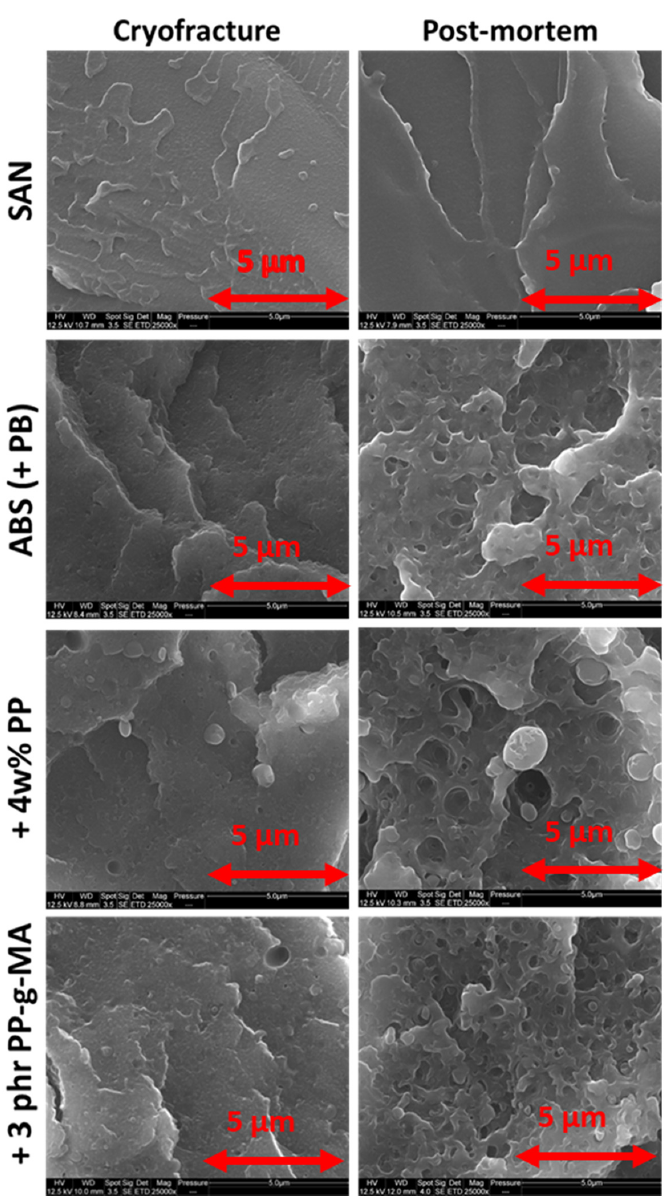
Figure 13. Cavitation phenomena observed on post-mortem tensile tests fragments through SEM—comparison to cryofractured samples—virgin SAN, virgin ABS, and ABS contaminated with 4 wt% PP and ABS contaminated with 4 wt% PP with 3 phr of PP-g-MA.